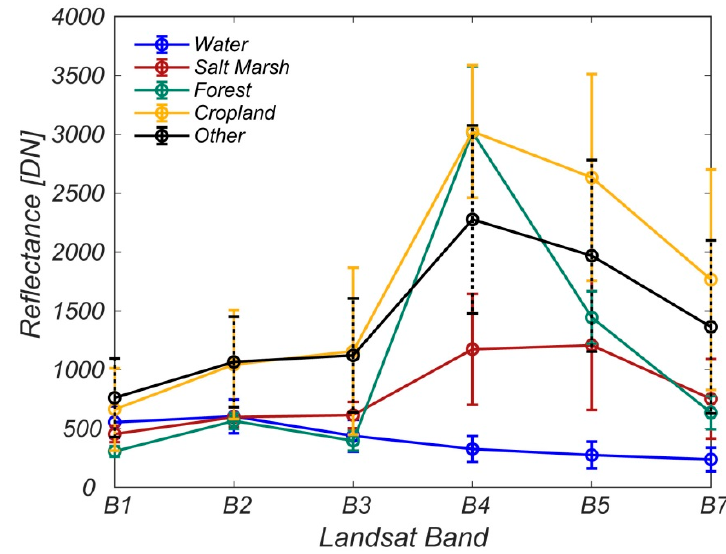
Figure 3. Multi-spectral surface reflectance curves for the five classes. Nodes represent the mean value and error bars represent standard deviations. Table 2. Stratified random sample size and unit allocation for accuracy assessment.